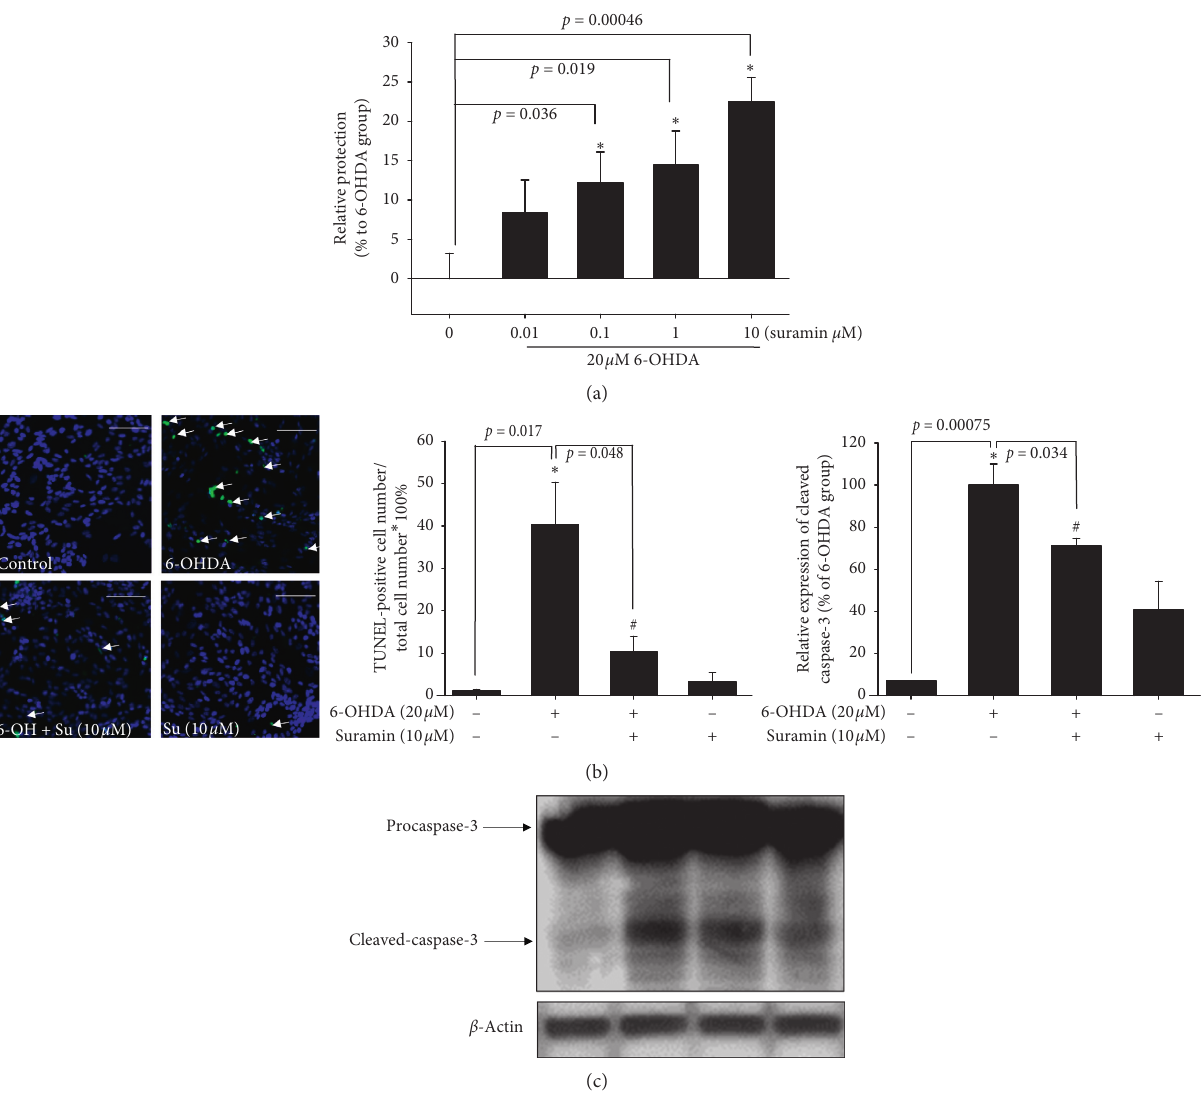
Figure 2: The neuroprotective effect of suramin on 6-OHDA-induced damage in SH-SY5Y cells. (a) SH-SY5Y cells were pretreated with 0.01, 0.1, 1, and 10 μ M suramin for 1h and then challenged with 20 μ M 6-OHDA for 16h in the control, 6-OHDA, 6-OHDA plus suramin, and suramin alone groups. The 6-OHDA-treated group was normalized as 0%. Data are presented as mean ± SEM, and each value contains three replicates and six samples. ∗ Significantly different from the 6-OHDA group. (b) SH-SY5Y cells were pretreated with 10 μ M suramin and then challenged with 20 μ M 6-OHDA for 8 h in the control, 6-OHDA, 6-OHDA plus suramin, and suramin alone groups. TUNEL staining was performed, and white arrows represent apoptotic cells (scale bar, 100 μ M). The quantification of apoptotic cells is shown. (c) Western blotting of cleaved caspase-3 protein and quantification of each group. Data are presented as mean ± SEM, and each value contains three replicates and six samples. ∗ Significantly different from the control group; # significantly different from the 6-OHDA